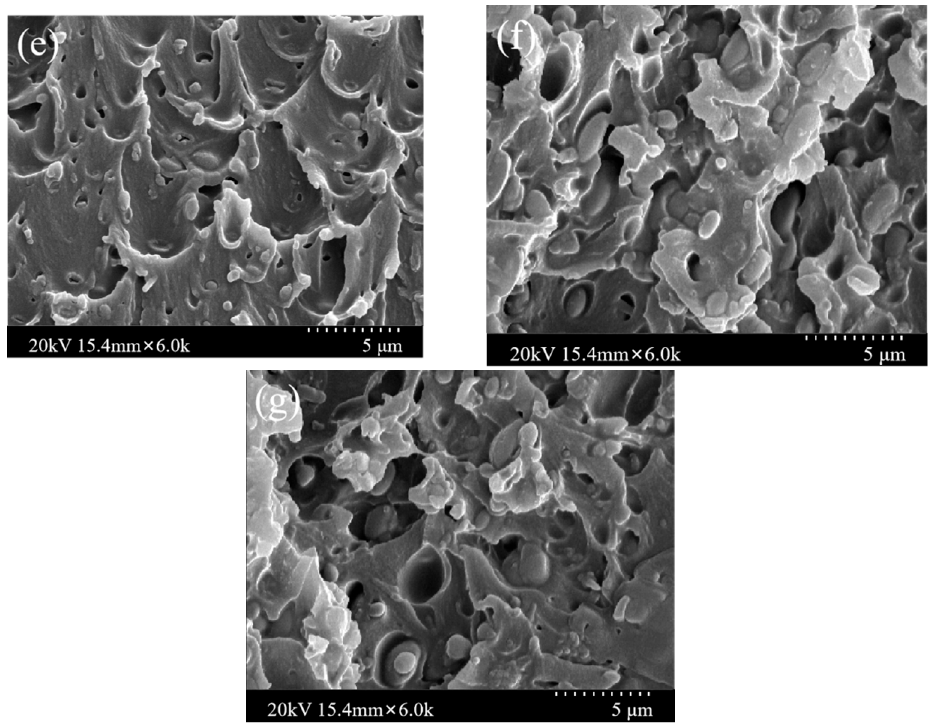
Figure 3. SEM images of the cross-section of pure PI ( a ), PI-IL ( b ) and PI-IL/1–5%MOF mixed matrix membranes ( c – g ).